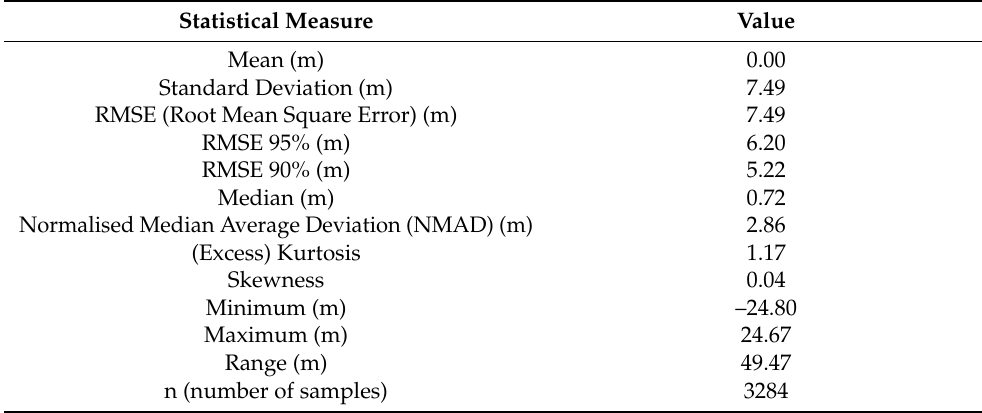
Figure 15. Histogram of relative bathymetric model errors. Table 3. Descriptive and other statistics for the relative bathymetric model errors.